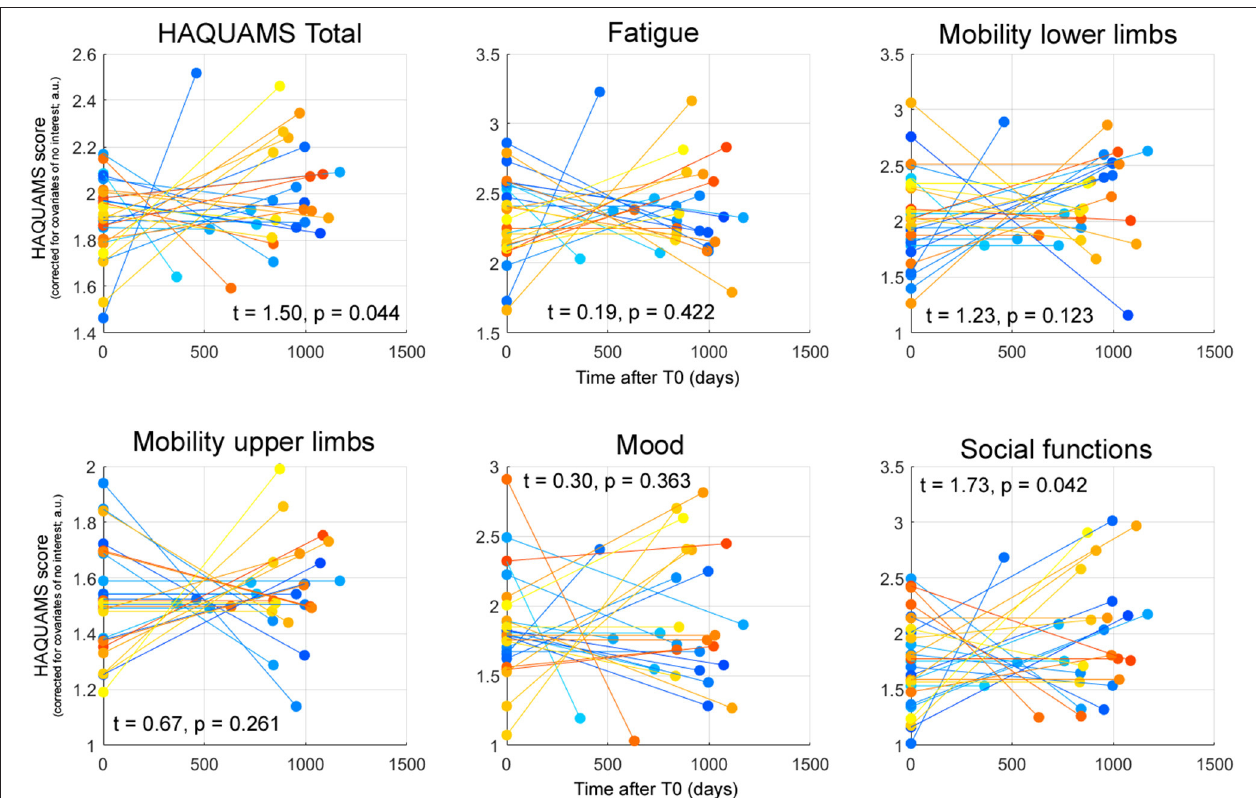
FIGURE 3 | Patient-specific HAQUAMS scores for overall HRQoL and five HAQUAMS subscales at T0 and T1 corrected for the CNI mentioned in the text. Each line depicts the trajectory of the given marker for an individual participant. The t -statistics and p -values reported characterizing the effect of time on each given parameter across all 28 PwMS. It is noted that higher scores correspond to less HRQoL, positive t -statistics to a (not necessarily significant) increase of a marker across time (and thus to a not necessarily significant HRQoL